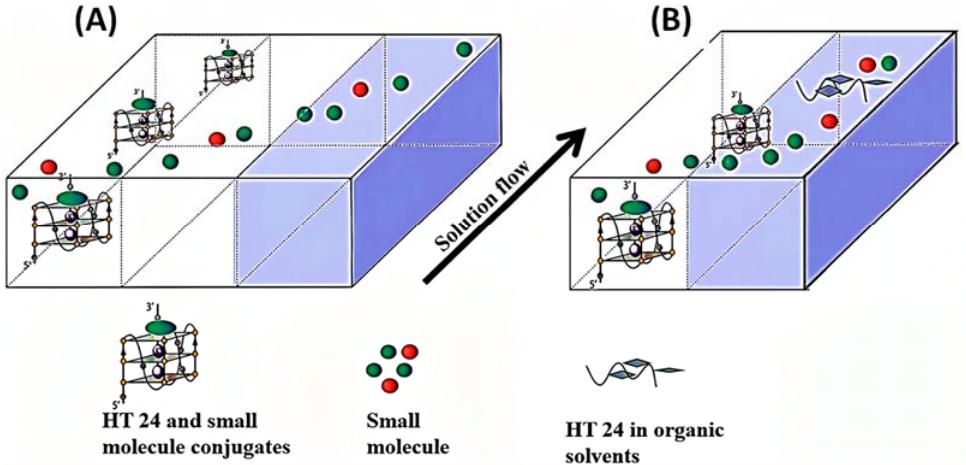
Figure 10. Schematic diagram of the microfluidic chip separating free compounds: three ‐ phase microfluidic chip ( A ) and two ‐ phase microfluidic chip ( B ). The image from [11], Copyright 2020, Elsevier.